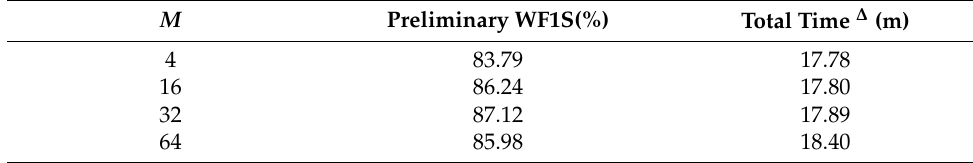
Table 4. The effect of the number of attention maps evaluated on the C-NMC dataset.